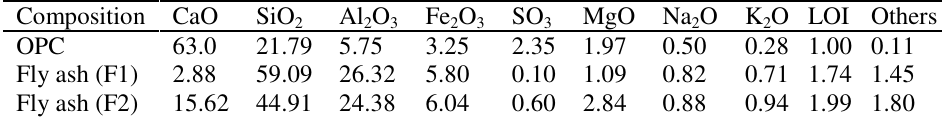
Table 1. Results of the chemical analysis (wt %).